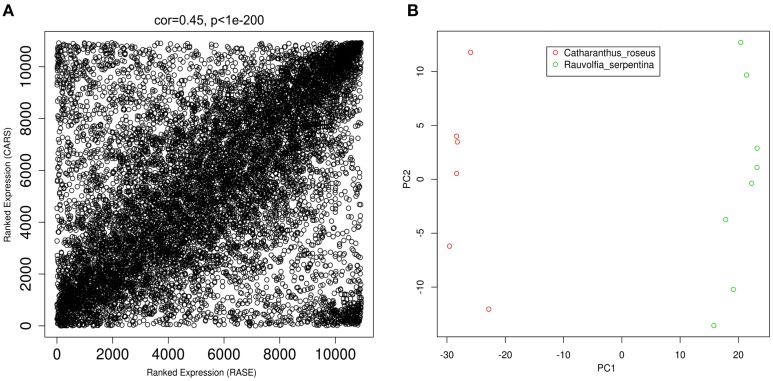
(A) Ranked expression correlation between two data sets samples. Each dot depicts a gene in common between data sets, where x and y axes represents ranked expression of genes in samples from R. serpentina and C. roseus datasets, respectively. (B) Principal component analysis (PCA) plot depict that all samples are clustered according to plant species inside the 2-dimensional space indicating clear differences in expression profiles. Red and green data points correspond to R. serpentina and C. roseus samples, respectively.